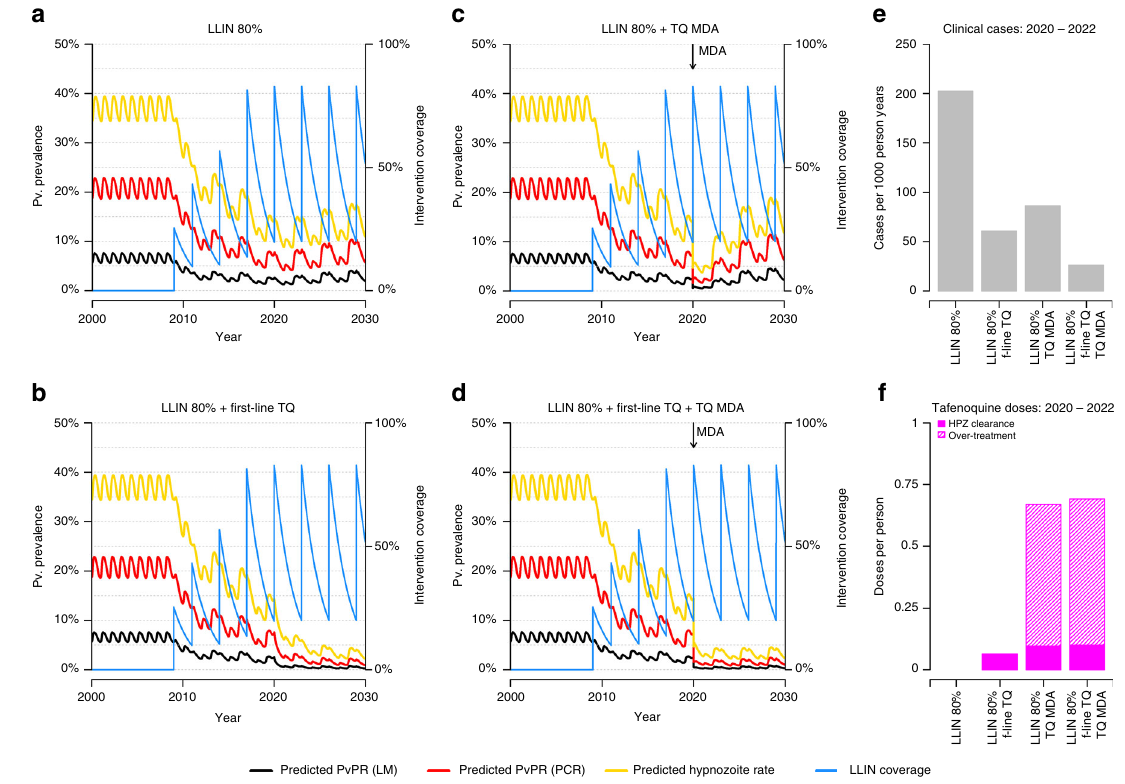
Fig. 5 Individual-based model projections of P. vivax transmission in New Ireland under a range of intervention scenarios. Model predictions are based on the median of 100 stochastic simulations. a LLIN campaign every 3 years at 80% coverage. b LLIN campaigns plus introduction of tafenoquine (TQ) into fi rst-line treatment regimen from 2020 such that 50% of clinical cases are treated. c LLIN campaigns plus mass drug administration (MDA)